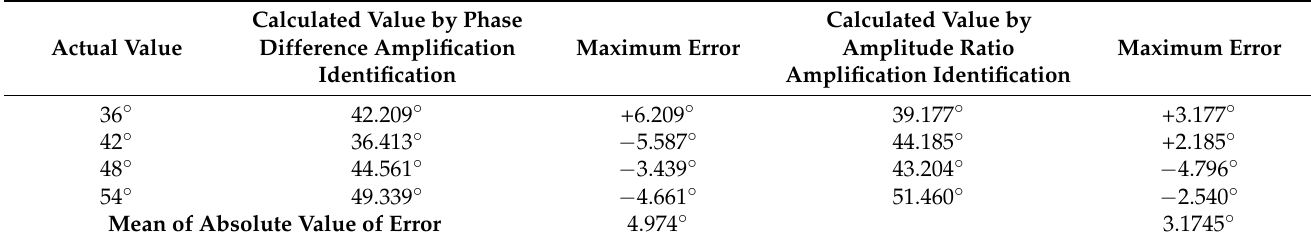
Table 2. Comparison of the calculated value and the actual